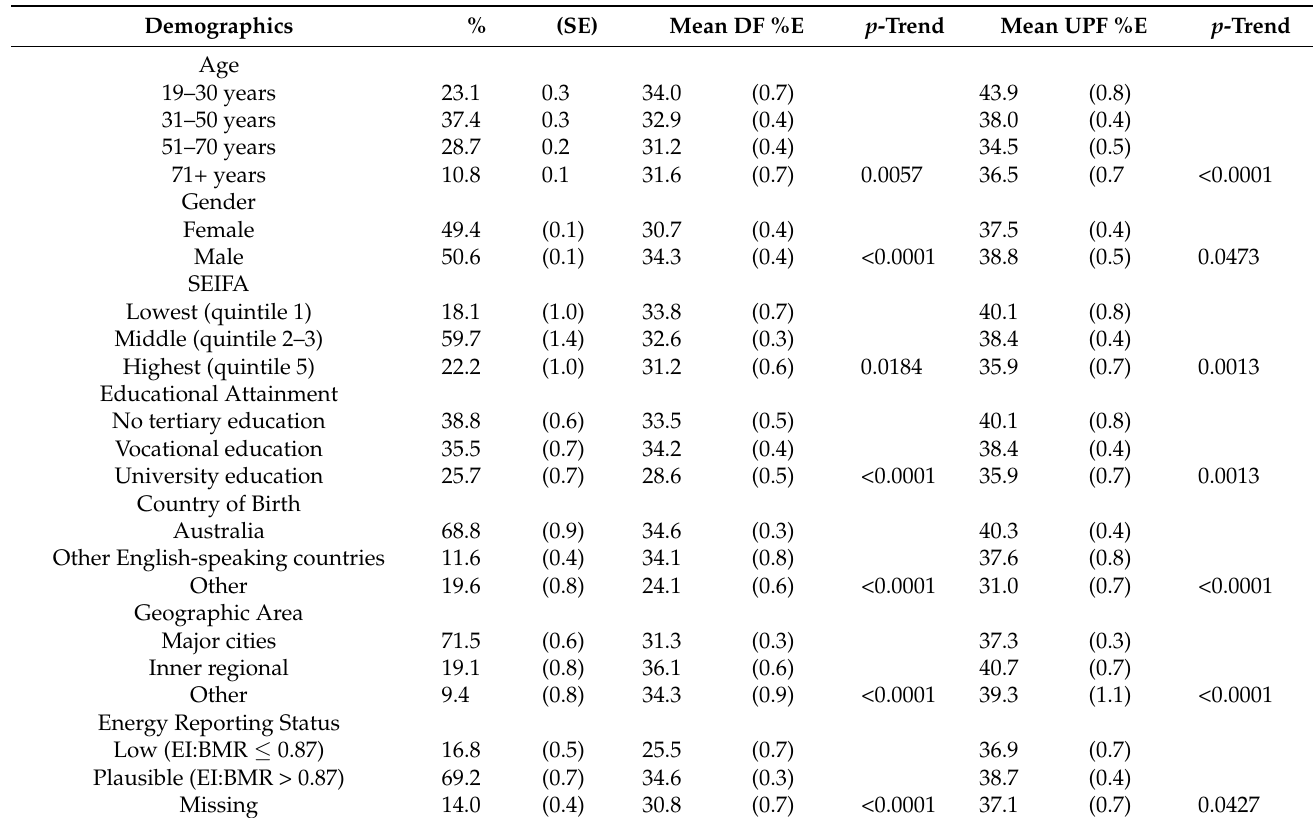
Table 2. Percentage energy for discretionary food (DF) and ultra-processed foods (UPF) by demo- graphics for Australian adults ( n =